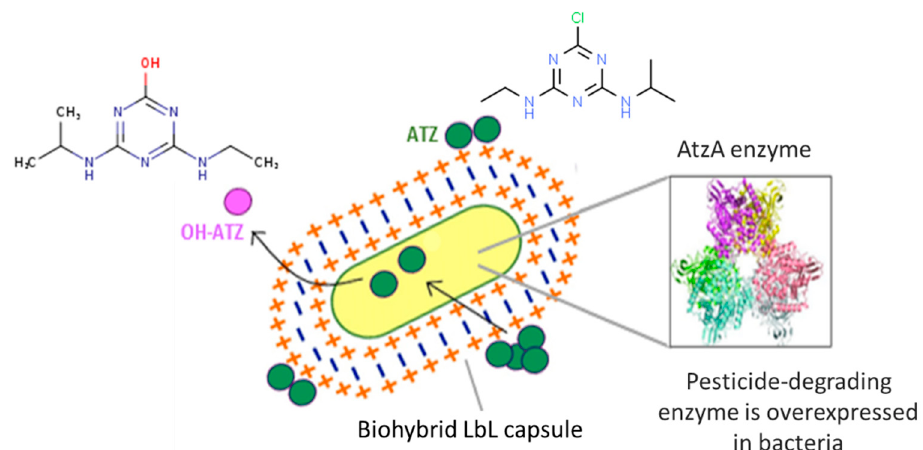
Figure 1. Illustration of the biohybrid LbL capsule based on alternating, oppositely charged polyelec- trolytes, coating bacteria overexpressing the enzyme AtzA.